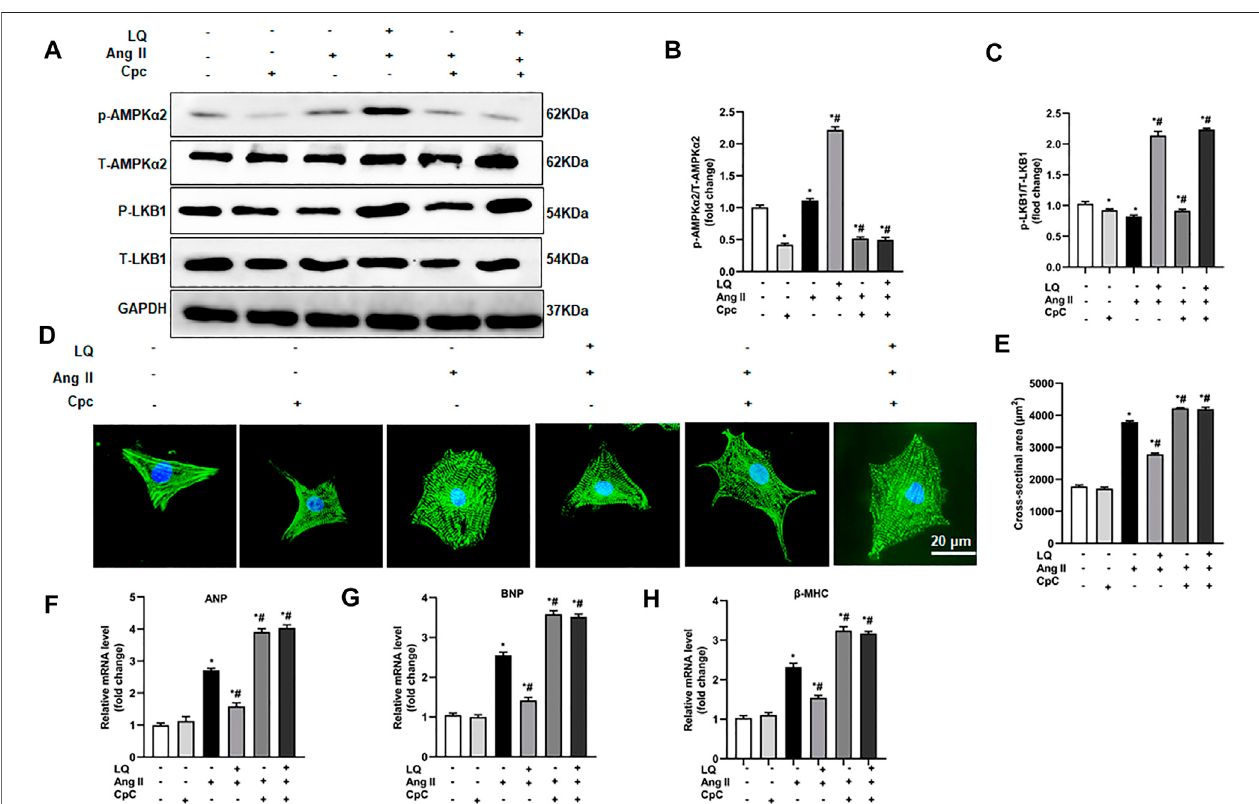
FIGURE 8 | AMPK inhibition abolishes liquiritin ’ s protective effect against Ang II-induced cardiomyocyte hypertrophy. (A) Representative immunoblots for p-AMPK α 2,T-AMPK α 2,p-LB1,andT-LKB1.Relativeexpressionlevelsof (B) p-AMPK α 2/T-AMPK α 2and (C) p-LKB1/T-LKB1basedonwesternblotresults( n =6). (D) Representativeimagesof α -actininimmuno fl uorescence(green)inNRCMs.NucleiwerestainedwithDAPI(blue). (E) CSAestimationsbasedonquanti fi cationofa-actinin immuno fl uorescence in NRCMs ( n = 6 replicates per group). Relative mRNA expression levels of (F) ANP, (G) BNP, and (H) β -MHC in NRCMs ( n = 6). All in vitro experiments were repeated three times independently. Data are presented as the mean ± SEM. One-way ANOVA was performed to examine statistical differences among different groups. * p < 0.05 vs. the corresponding PBS + Veh group; # p < 0.05 vs. Ang II +